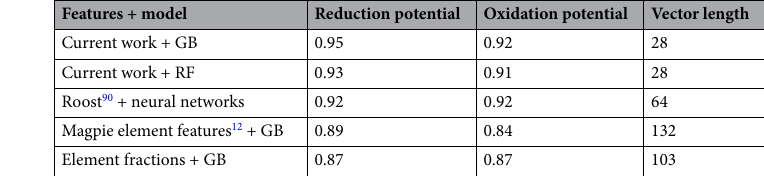
Table 5. The cross-validated performance of our RF and GB models trained using 28 input features on the oxidation and reduction potential prediction tasks. Also compared are three other composition-based representations from literature (with the same GB model in each